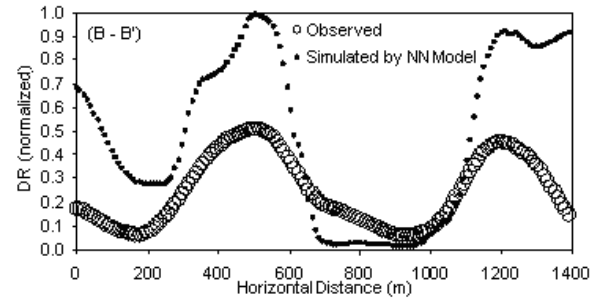
Fig. 12. The observed and simulated damage ratios for cross section B–B 0 (NN trained by Group A